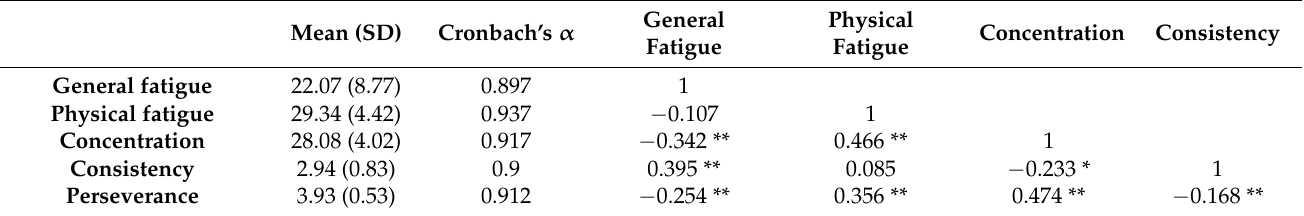
General Physical Concentration Consistency Fatigue Fatigue